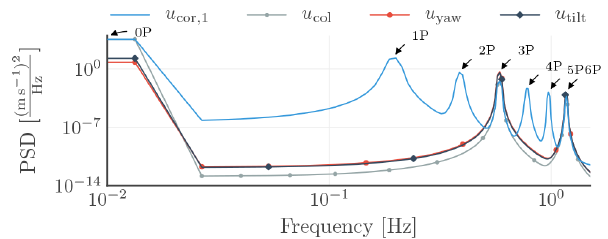
Figure 7. Power spectral densities of the generic signals in the ro- tating ( u cor , 1 ) and non-rotating ( u col , u yaw , u tilt ) frames of refer- ence during the application of the multiblade coordinate transfor- mation.